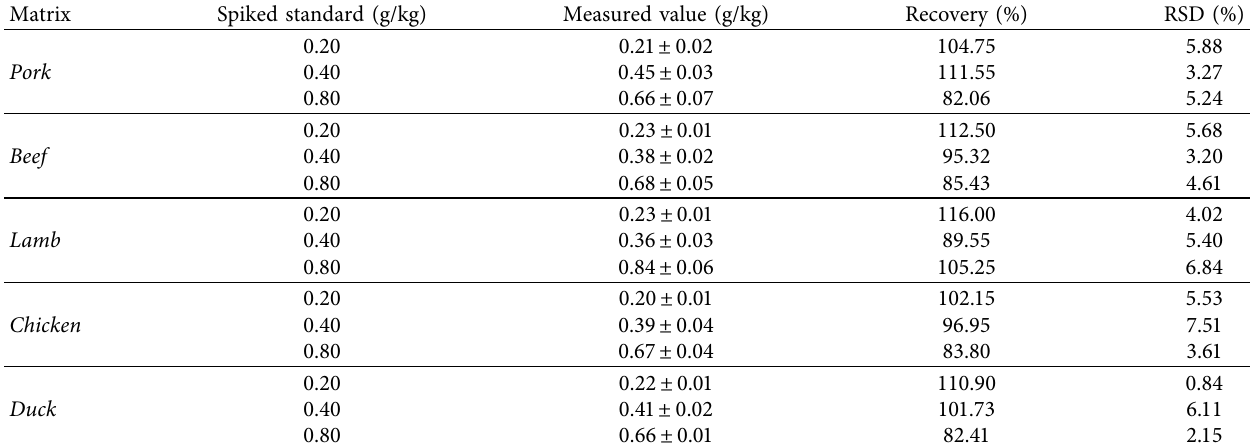
Table 3: Analysis of carrageenan in commercial livestock and poultry meat and meat-based products ( n � 6). Sample Place of production Pork Jiangsu, China Lamb